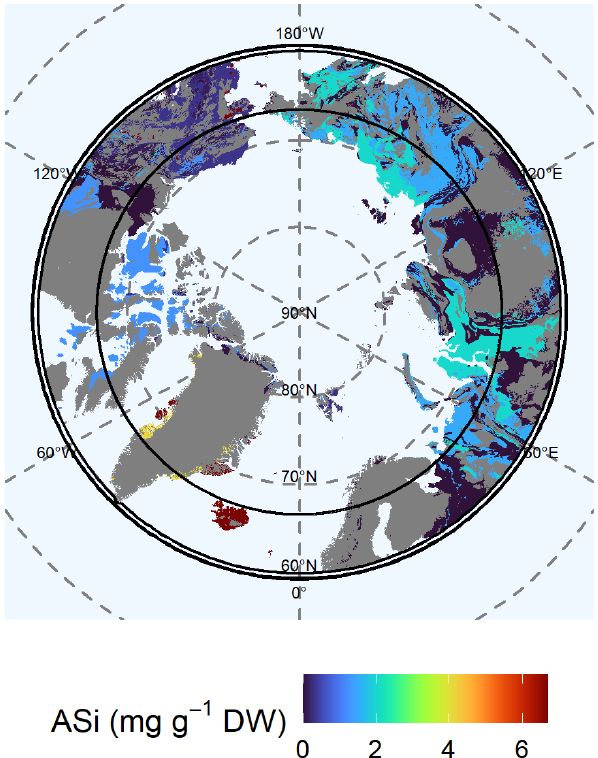
Figure 3. Map of the mean concentration of amorphous silicon (ASi) in the top 100cm of soils. For each lithological class, the mean concentration is shown. Gray shaded areas are not represented by our